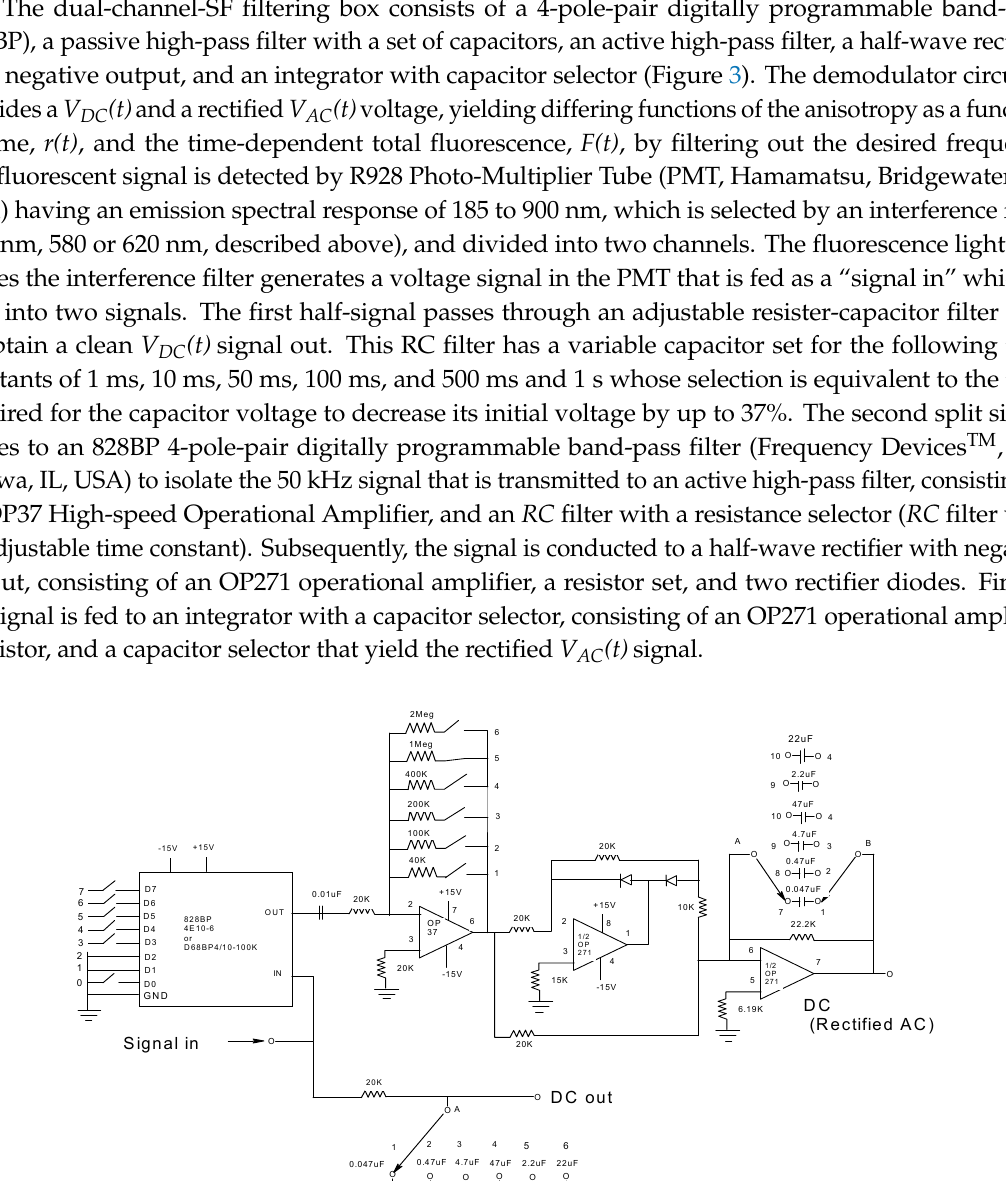
Figure 3. Circuit diagram for the dual-channel SF filtering box. The frequency selection circuitry filtered out the r(t) , and F(t) traces by getting the ratio of V AC (t) / V DC (t) , according to Equation (7)